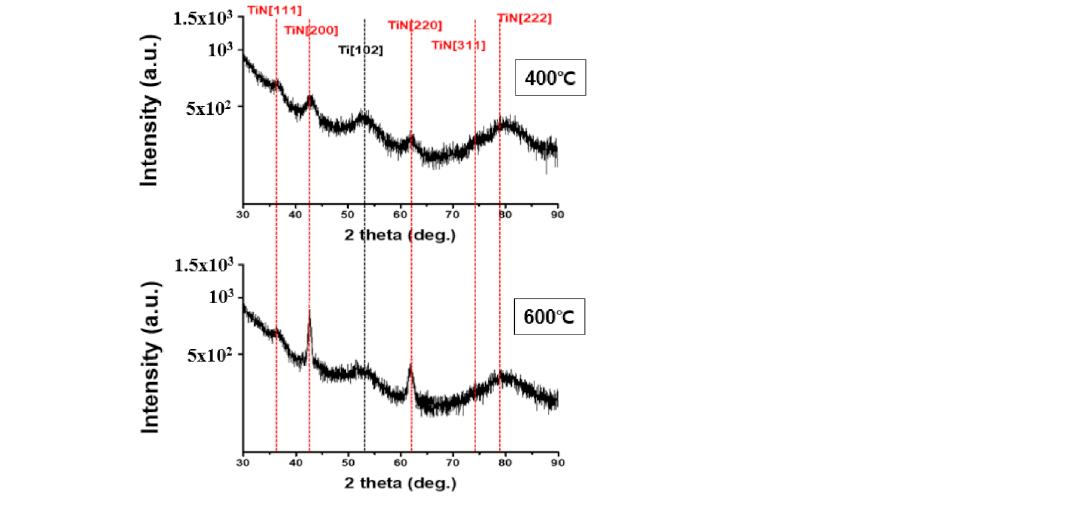
Figure 4. XRD analysis to determine the crystal structure of TiN thin films based on deposition temperature.